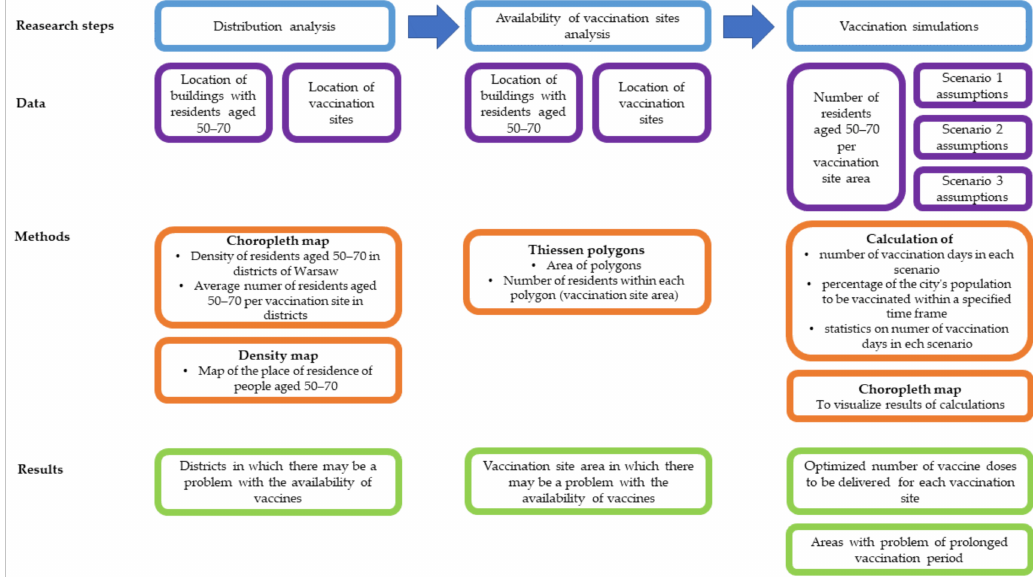
Figure 5. Methodology